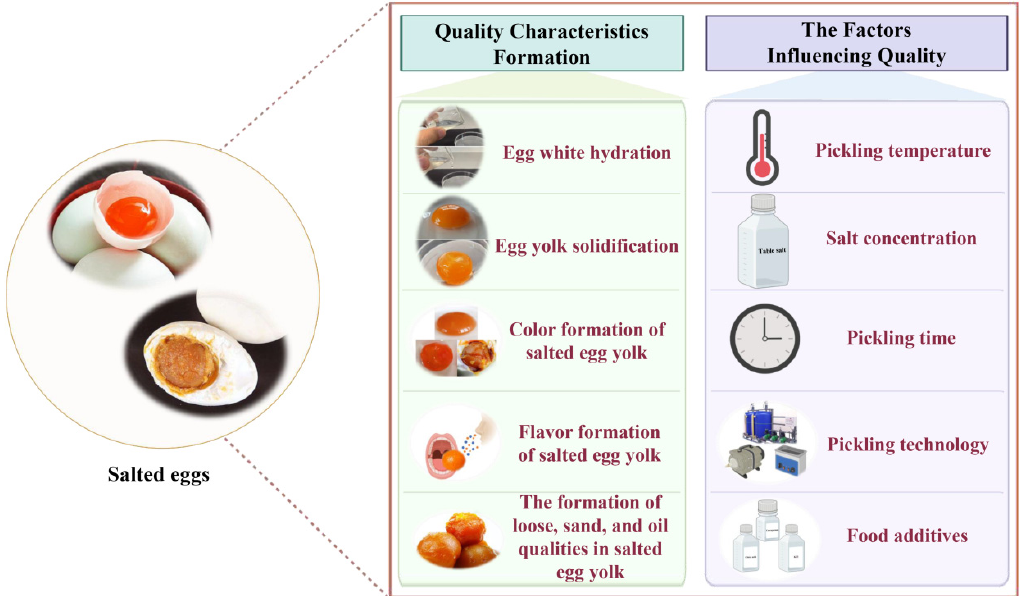
Figure 1. The formation of quality characteristics and the factors affecting the quality of salted